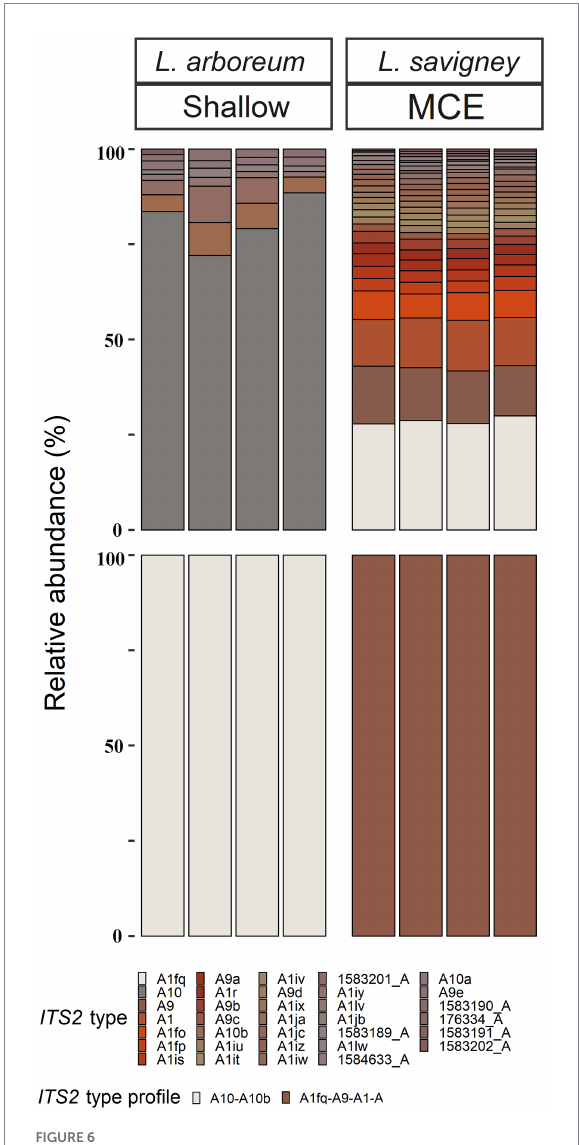
FIGURE 6 Normalized relative abundance of members of Symbiodinium in octocoral host species from shallow and mesophotic zones in the Gulf of Aqaba/Eilat. Relative abundances of ITS2 sequences and predicted ITS2 type-profiles (above and below, respectively) arranged by octocoral species and depth zone. Only the >0.01% most abundant sequences are displayed ( n = 33). Sequences not used in the definition of ITS2 type profiles are given a unique database ID number followed by a letter referring to the genus the sequence is from (e.g., 1,583,189_A is a sequence from the genus Symbiodinium with the database ID